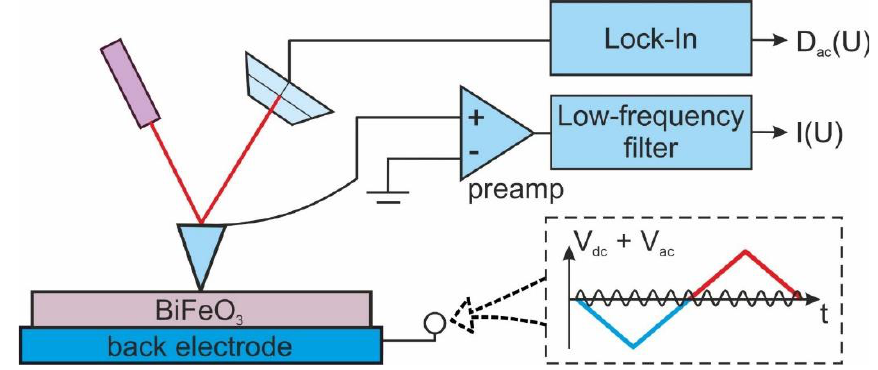
Figure 1. Experimental setup for simultaneous measurements of the current and piezoresponse.